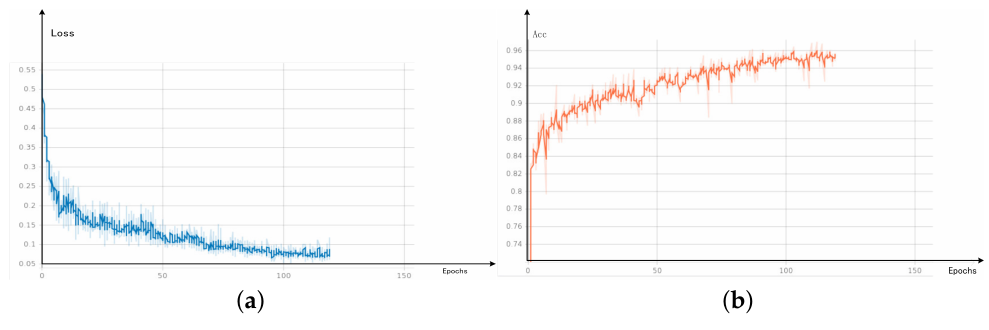
Figure 8. Visual results ( a ) loss ( b )